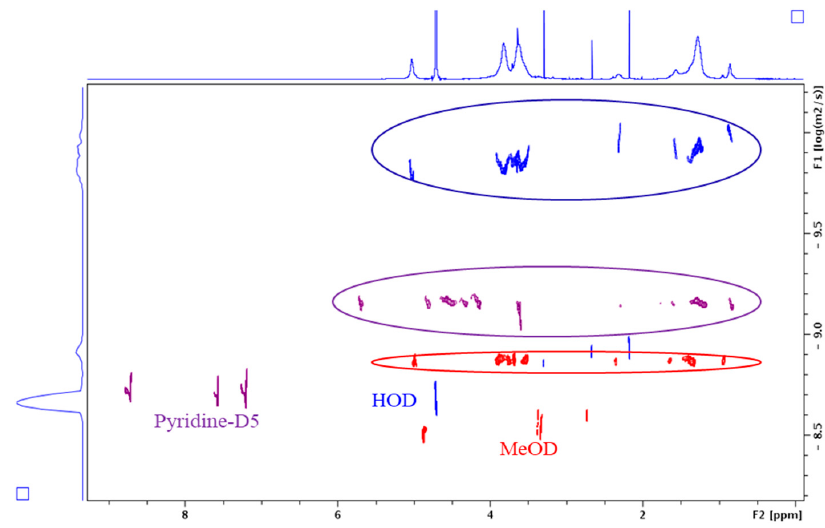
Figure 4. Overlapping DOSY maps obtained for 1 in D 2 O (blue spots), pyridine-D 5 (purple spots), and MeOD (red spots) (12 mM, 600 MHz, 298 K).